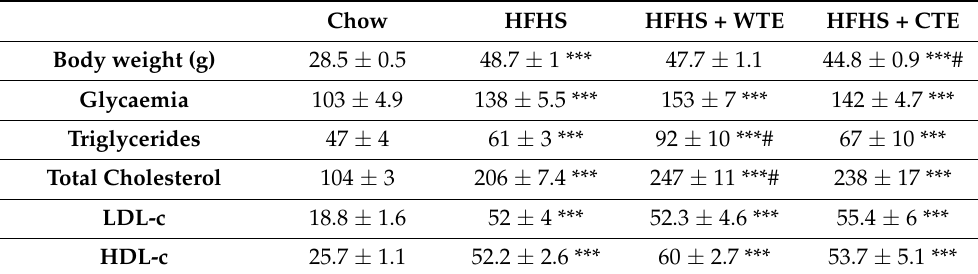
Table 1. Body weight (g), glycaemia (mg/dl), circulating levels of triglycerides (mg/dL), total cholesterol, LDL-cholesterol (LDL-c) and HDL cholesterol (HDL-c). The values are represented as the mean ± S.E.M (n = 7–10 samples/experimental group). *** p < 0.001 vs. Chow; # p < 0.05 vs. HFHS.